Question: In a single sentence, describe what this figure presents.
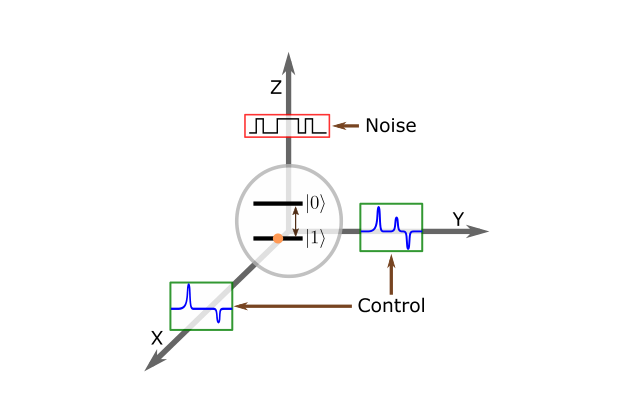
Answer: The model studied in the paper. A qubit is sub- jected to a random telegraph noise along the Z-axis. Control pulses are applied on the X- and Y- axes, and the target is to implement a desired quantum gate.